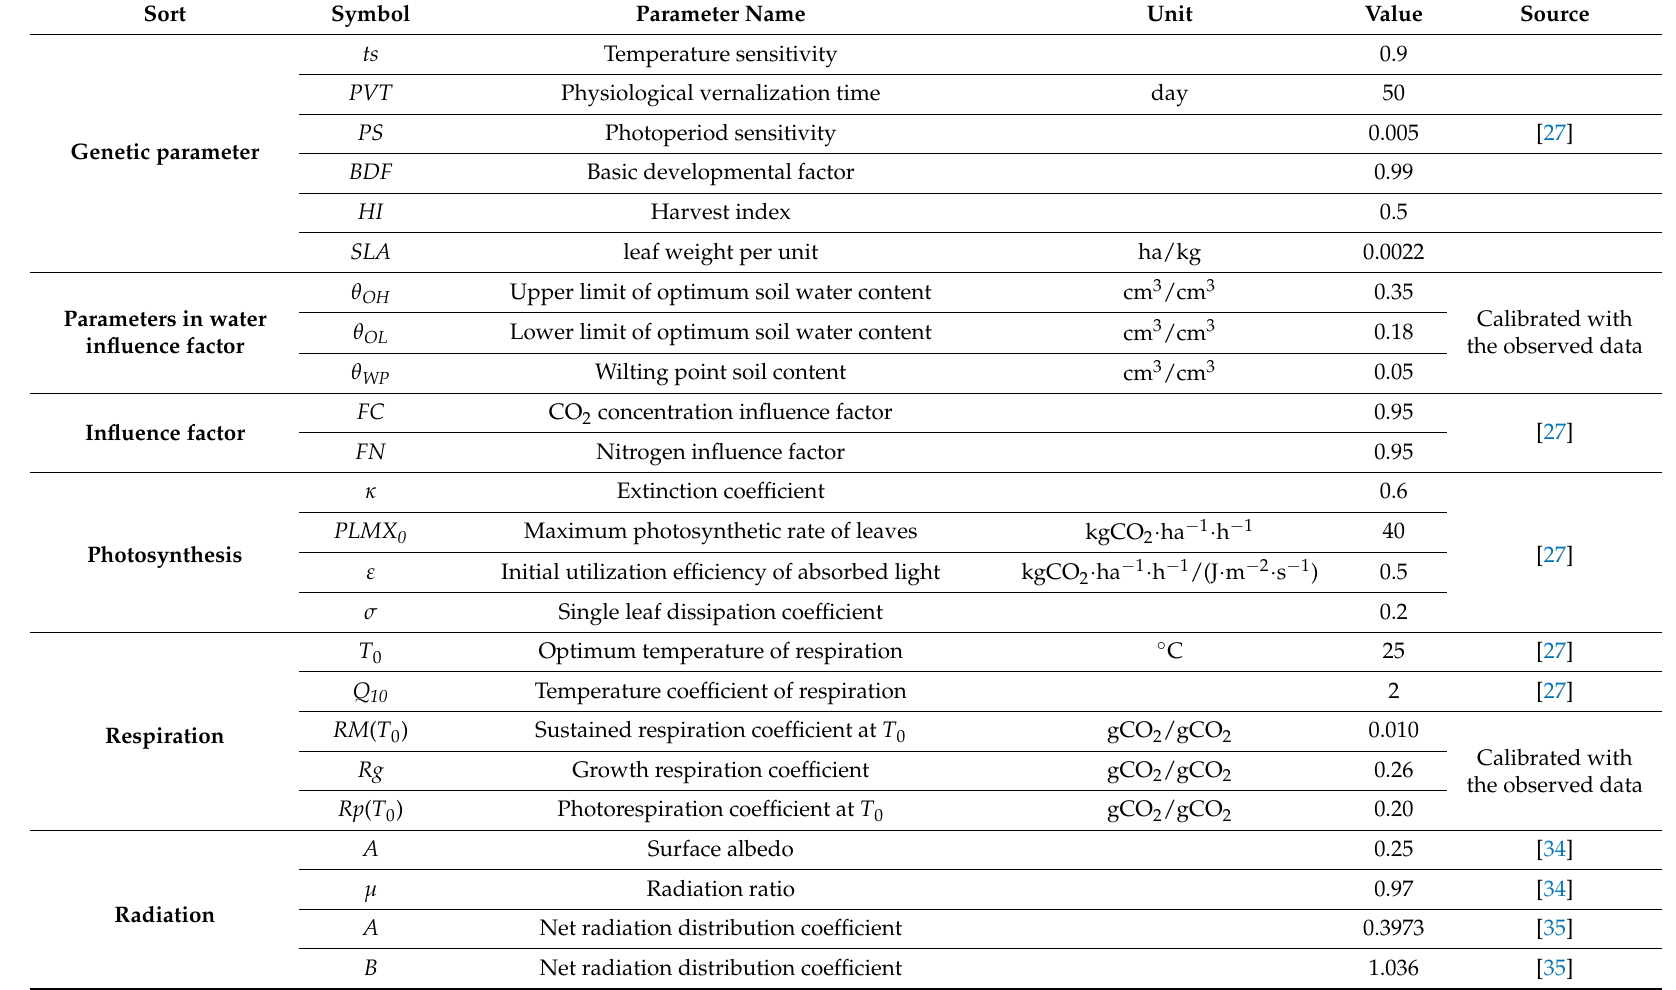
Table A2. Parameter values of the